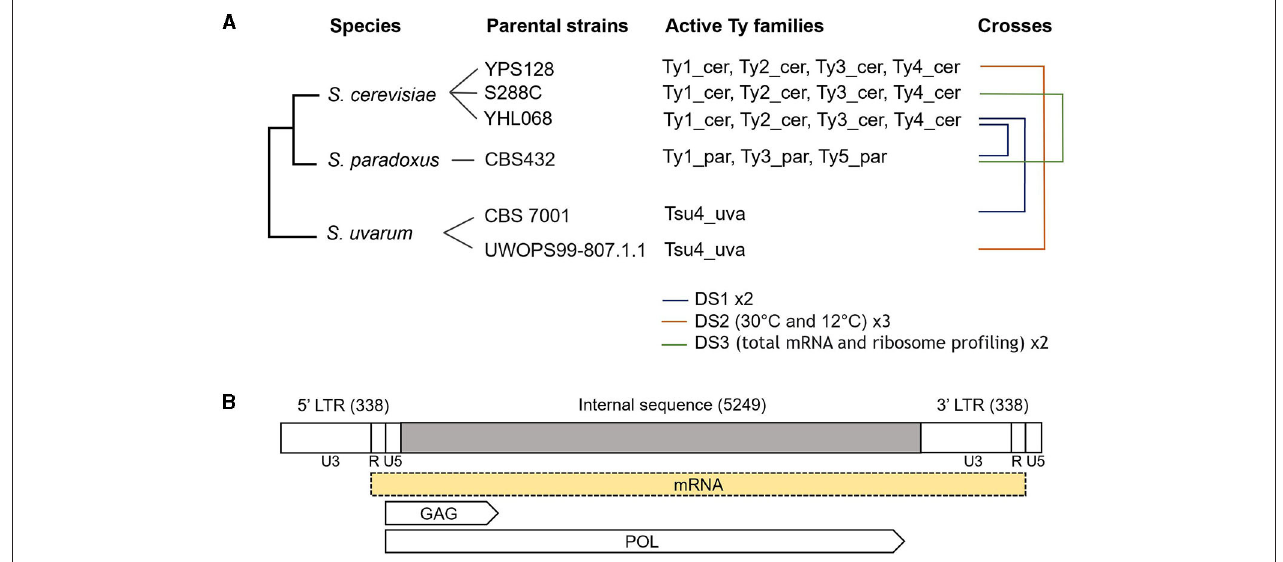
FIGURE 1 | (A) Experimental design of the crosses performed in the three expression datasets. The phylogenetic tree (not to scale) details parental species and strains used, as well as their Ty family content. Active families are defined as comprising at least one full-length element, with a complete internal sequence and two flanking LTRs. To distinguish Ty families that are orthologous across parental species, family names are complemented with their host species (Ty1_cer corresponding to Ty1 from S. cerevisiae ). Brackets show the crosses from DS1 ( Schraiber et al., 2013), DS2 (Hovhannisyan et al., 2020), and DS3 (McManus et al., 2014). Number of samples per cross and specific conditions of the datasets are indicated in the legend. (B) Annotations of a Ty1 full-length sequence (not to scale). The length of the internal and LTR sequences are indicated between parentheses. The GAG and POL overlapping open reading frames (ORFs) are represented by arrows delimited by their respective start and stop codons. The GAG start codon is 40 bp upstream of the end of the 5 ′ LTR and the POL stop codon is 25 bp upstream of the beginning of the 3 ′ LTR. Ty1’s canonical transcript, which is represented by a yellow box, starts in the 5 ′ LTR (including the R and U5 regions) and ends near the end of the 3 ′ LTR (including the U3 and R regions). The figure is inspired from the Figure 5 of Curcio et al.